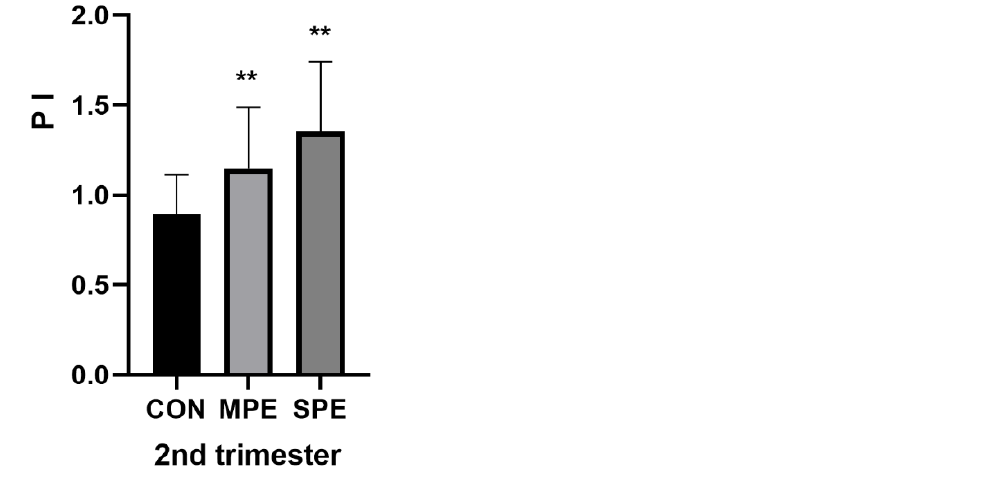
Figure 4. Uterine artery Doppler PI in the second trimester. CON, n = 60; MPE, n = 18; SPE, n = 33, ** p < 0.001. Table 3. Predictive efficiency of biomarker levels and PI for severe preeclampsia. Table 2. Comparison of biomarker levels among study groups.